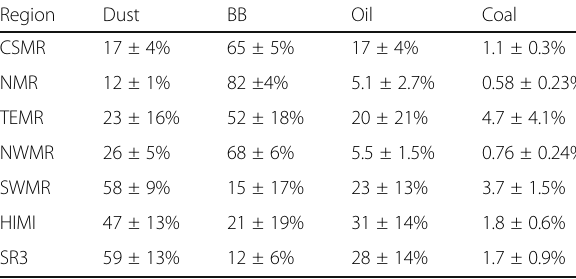
Table 4 A posteriori model estimates of L Fe for each region including the Australian marine regions (CSMR, NMR, TEMR, NWMR, and SWMR), as well as regions of the SO (HIMI and SR3). Atmospheric sources considered include dust (dust),